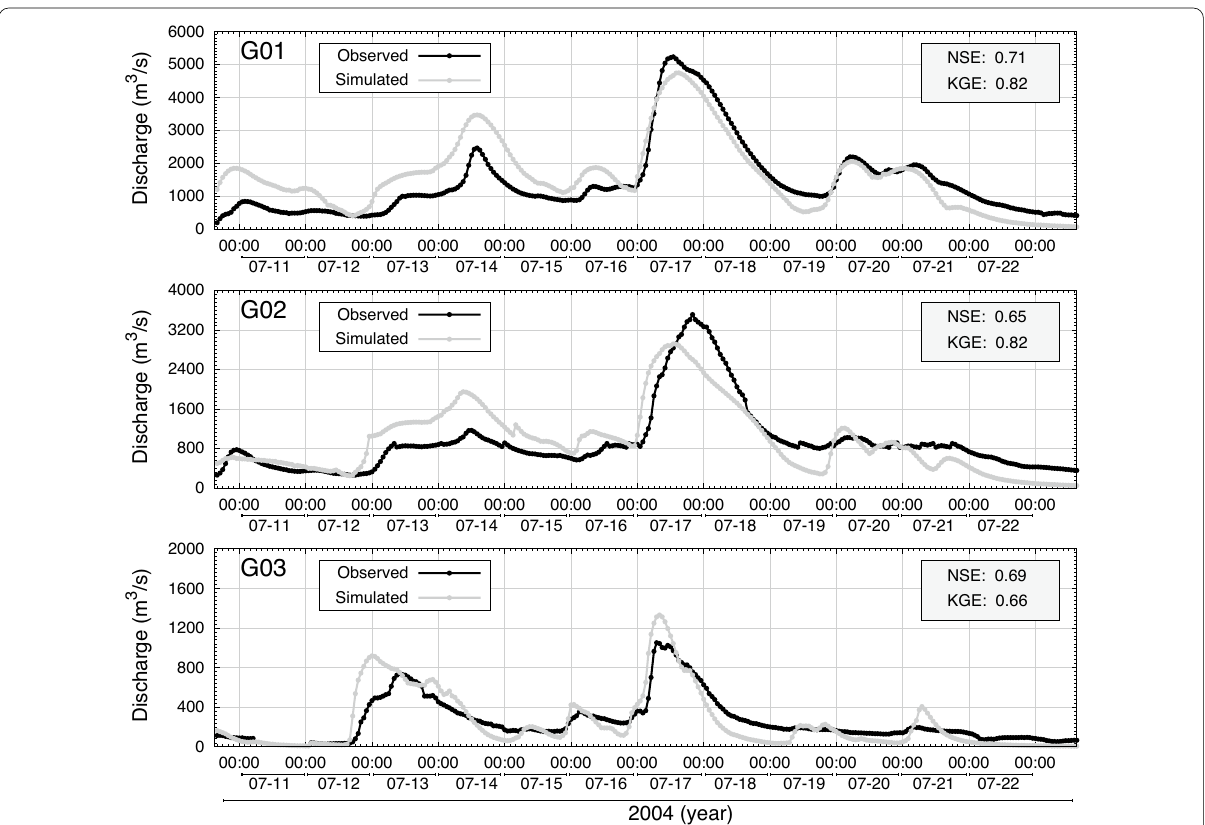
Fig. 2 Time-series profile of simulated discharge by RRI and observed discharge at three hydrological stations (G01, G02, and G03) for the event